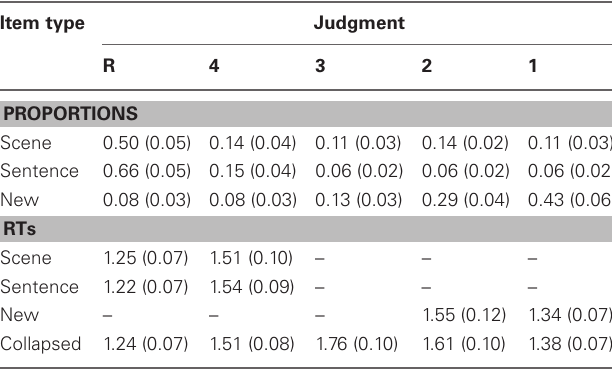
Table 1 | Mean proportions and response times (RTs, in seconds) of judgments for each item type in the retrieval